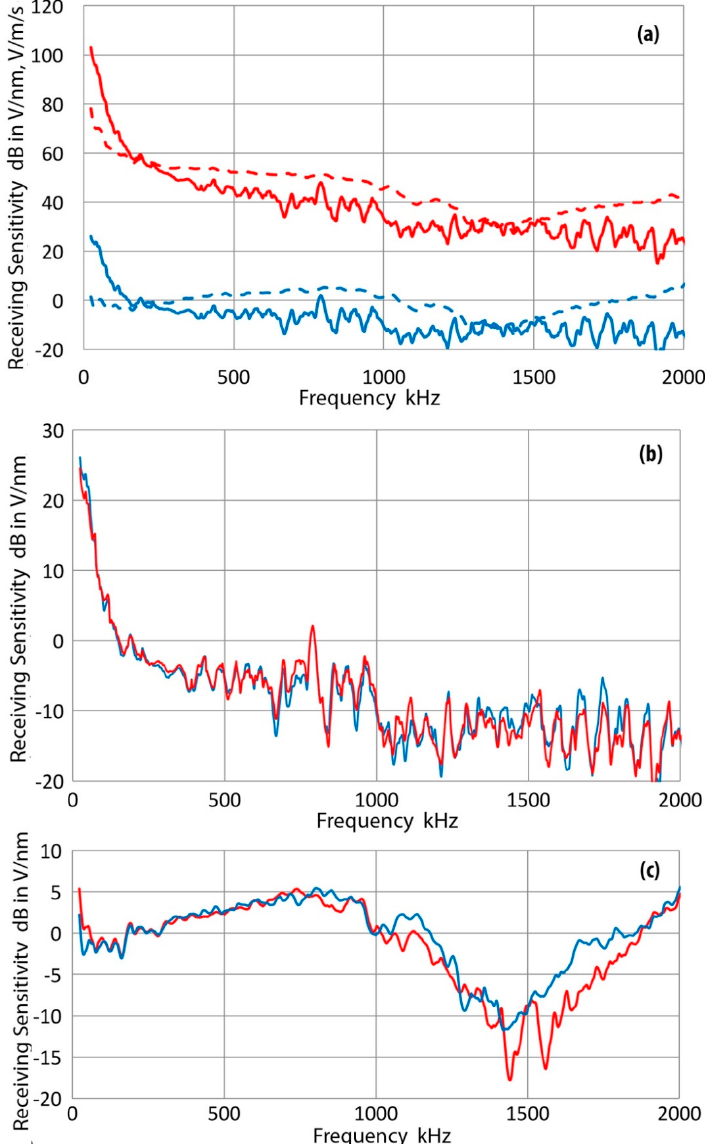
Figure 8. ( a ) Receiving sensitivity of a KRN sensor (#11063). The displacement receiving sensitivities are shown in blue curves and velocity sensitivities are in red. Solid lines are for the bar-wave data, while dashed curves are for the sensitivities to normally incident waves; ( b ) Displacement sensitivity curves for bar waves of two KRN sensors: blue for #11063 and red for #11053. The latter was shifted 4.4 dB, giving a good match for the two curves; ( c ) Displacement sensitivity curves for normally incident waves of two KRN sensors: blue for #11063 and red for #11053. The latter was shifted 3.0 dB, giving a good match for the two curves, except above 1.4 MHz.